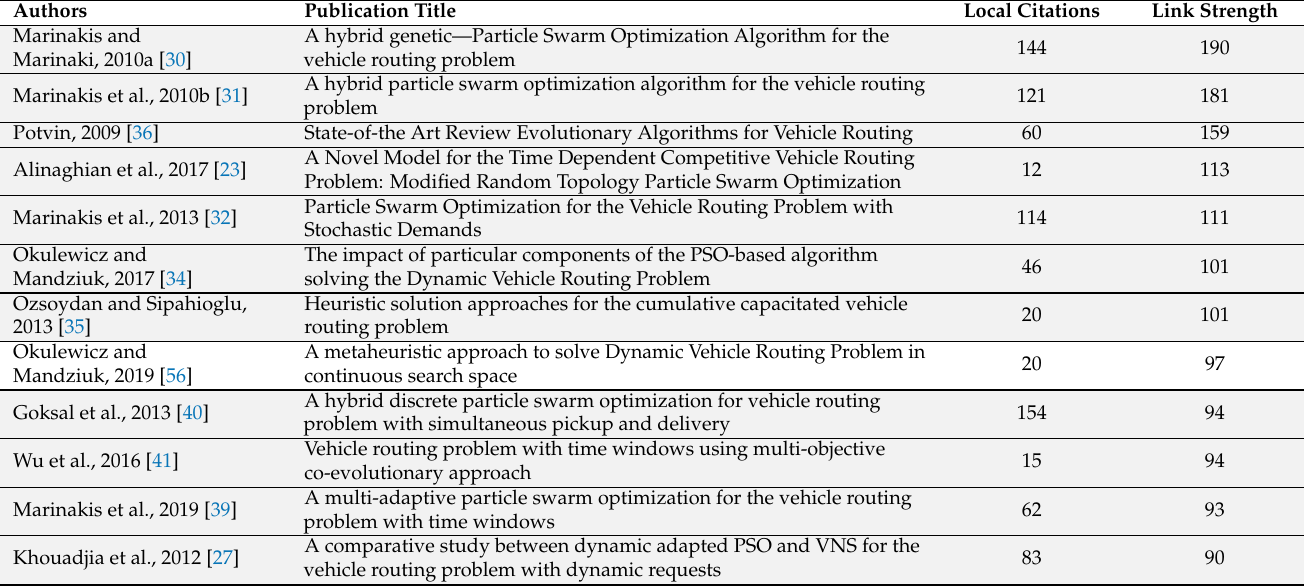
Table 8. Key bibliographically coupled PSO/VRP documents from the Web of Science query, n = 25/82.